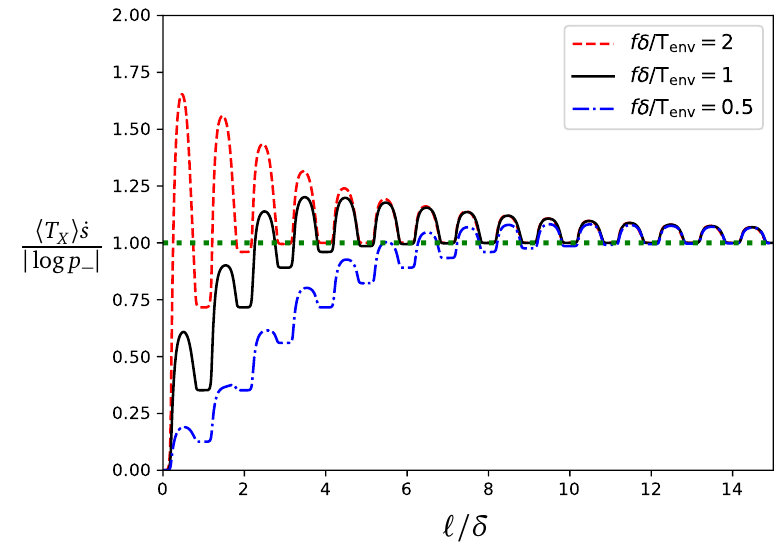
is the first-passsage time X